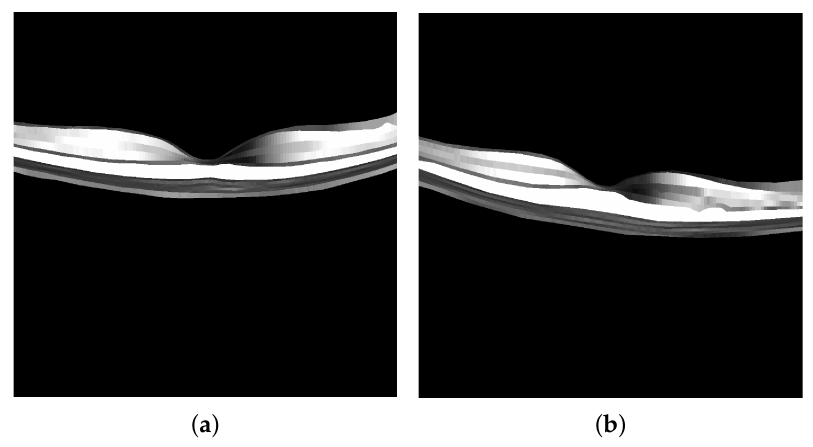
Figure 7. Thickness maps for ( a ) a normal subject and ( b ) a DR